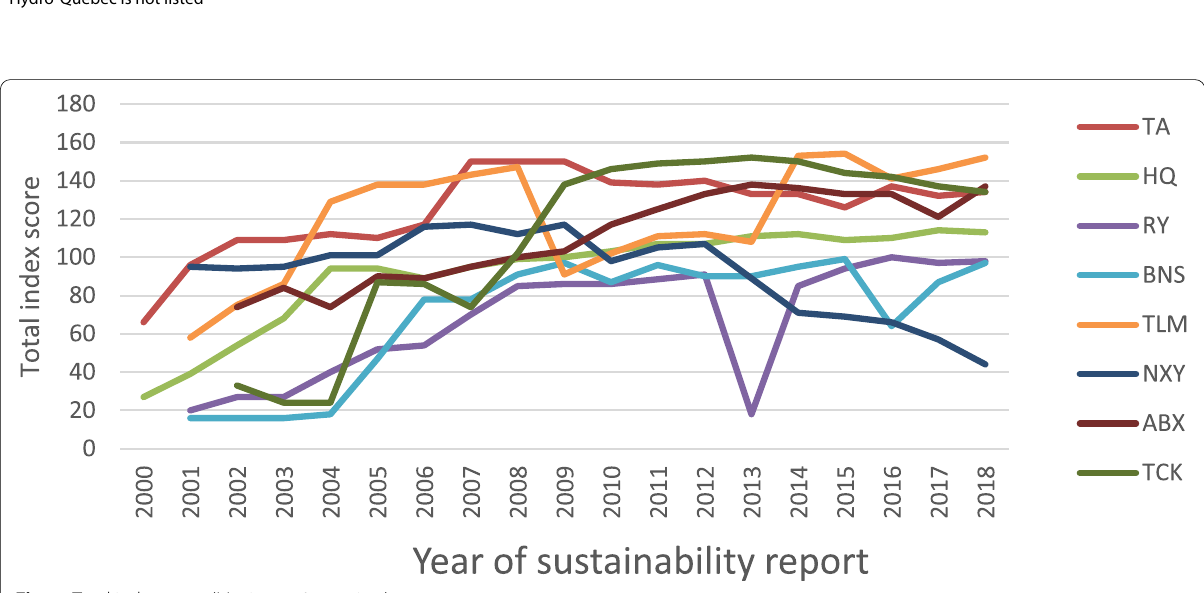
Fig. 1 Total index score (Maximum 255